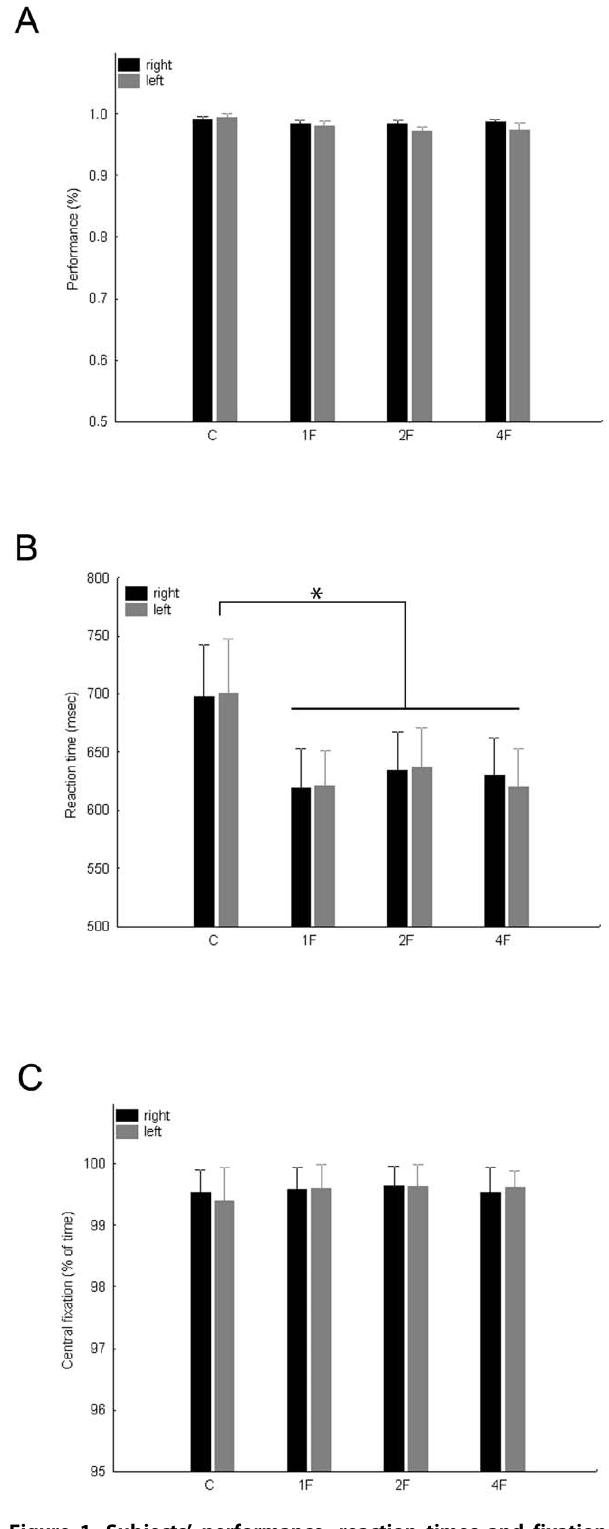
Figure 1. Subjects’ performance, reaction times and fixation performance in the behavioral control experiment separately for the Control (C), 1F, 2F (averaged across 2F0G, 2F1G and 2F2G conditions) and 4F conditions and for right (black) and left (gray) visual fields. A. Average detection performance. B. Average reaction times of the celebrity detection task. C. Eye-fixation performance expressed as proportion of trial-time (see Methods for details). Error bars represent standard error of means.